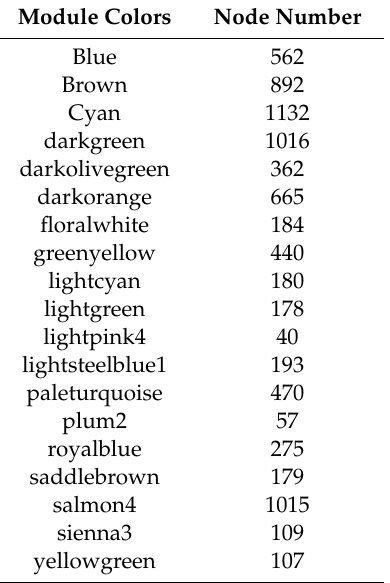
Table 1. The number of genes in 19 constructed